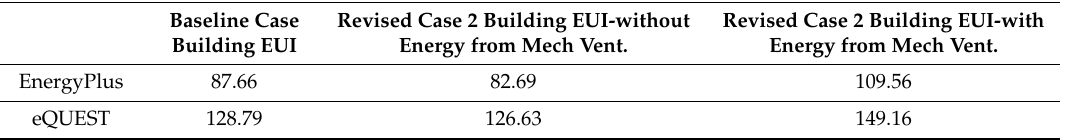
Table 6. Zonal Energy Use Intensity of Revised Cases from EnergyPlus and eQUEST (all figures in kWh / m 2 · year).